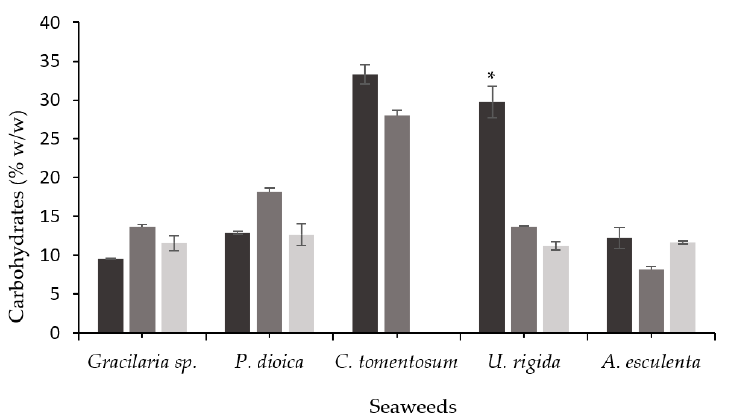
Figure 2. Carbohydrate content of unfermented seaweeds (black bars) and fermented seaweeds with A. ibericus MUM 03.49 (gray bars) and A. niger CECT 2915 (light gray bars). Results are presented as the mean (n = 3) ± SD. * denotes significant differences between unfermented and fermented solids